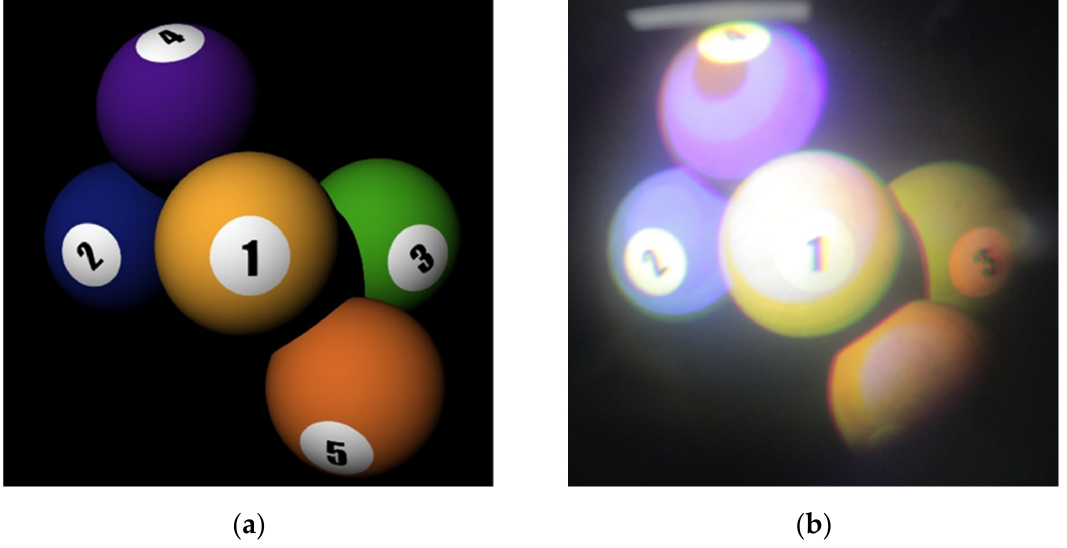
Figure 7. Single view at the second eye position of e 2 . ( a ) Target image; ( b ) captured image.